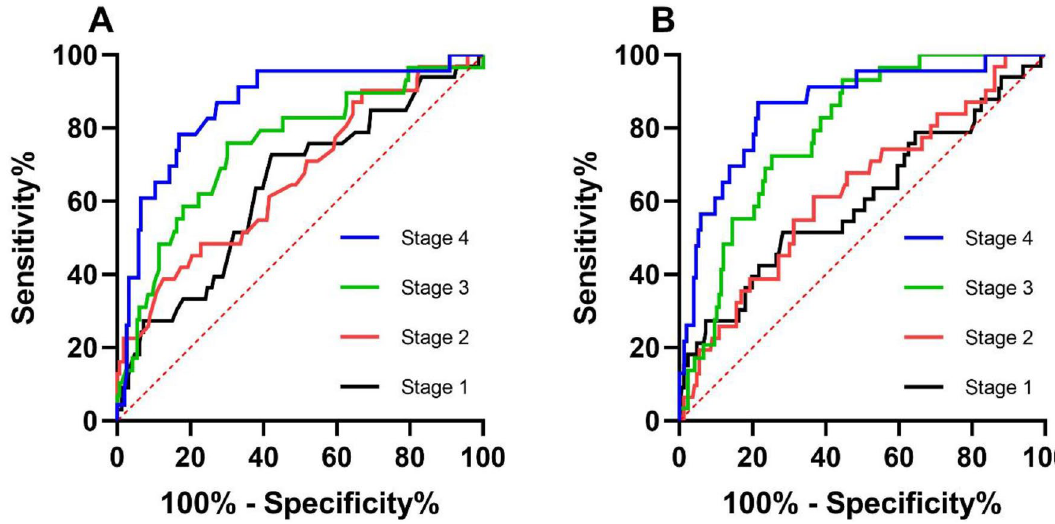
Figure 1. ROC curve of the albumin/prealbumin concentration for survival in SAP. ( A ) The ROC curve of albumin, and ( B ) the ROC curve of prealbumin.